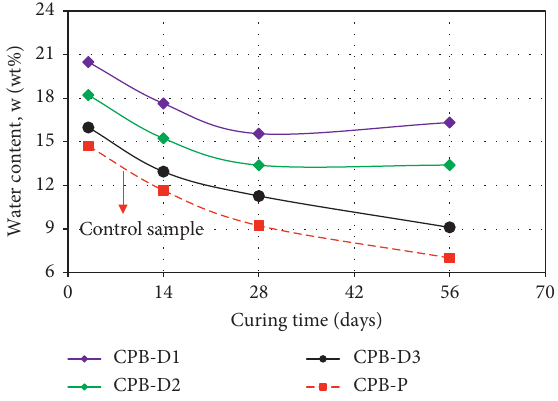
Figure 6: Change in water content with time for diverse mine backfills.